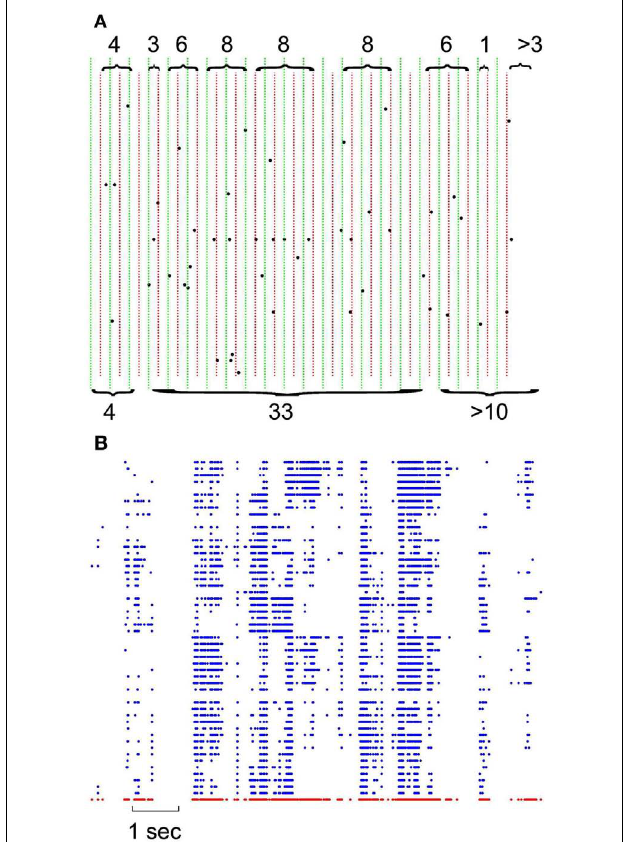
FIGURE 1 | Definition of avalanches. (A) Comparison of avalanche definition for 8 vs. 16ms binning; green vertical lines define the boundaries of 16ms binning; naturally, each 16ms bin is composed of 2 independent 8ms bin (depicted with red dotted lines). Accolades point to the avalanches, separated by quiescent periods.Top, 8ms avalanches and their sizes, bottom, 16ms avalanches and their corresponding size. Please note that last avalanche continues after of the limits in this figure. (B) Negative local maxima obtained from the grid of electrodes for a period of 10s. Each row represents negative maxima of a single LFP channel of a selected threshold level ≥ 1.75 × STD of the normalized LFP.The red dots in the bottom refer to ensemble presence of nLFP